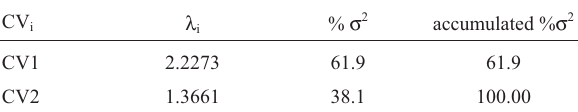
Table 1 - Canonical variables (CV i ), eigenvalues ( λ i ), and percent vari-